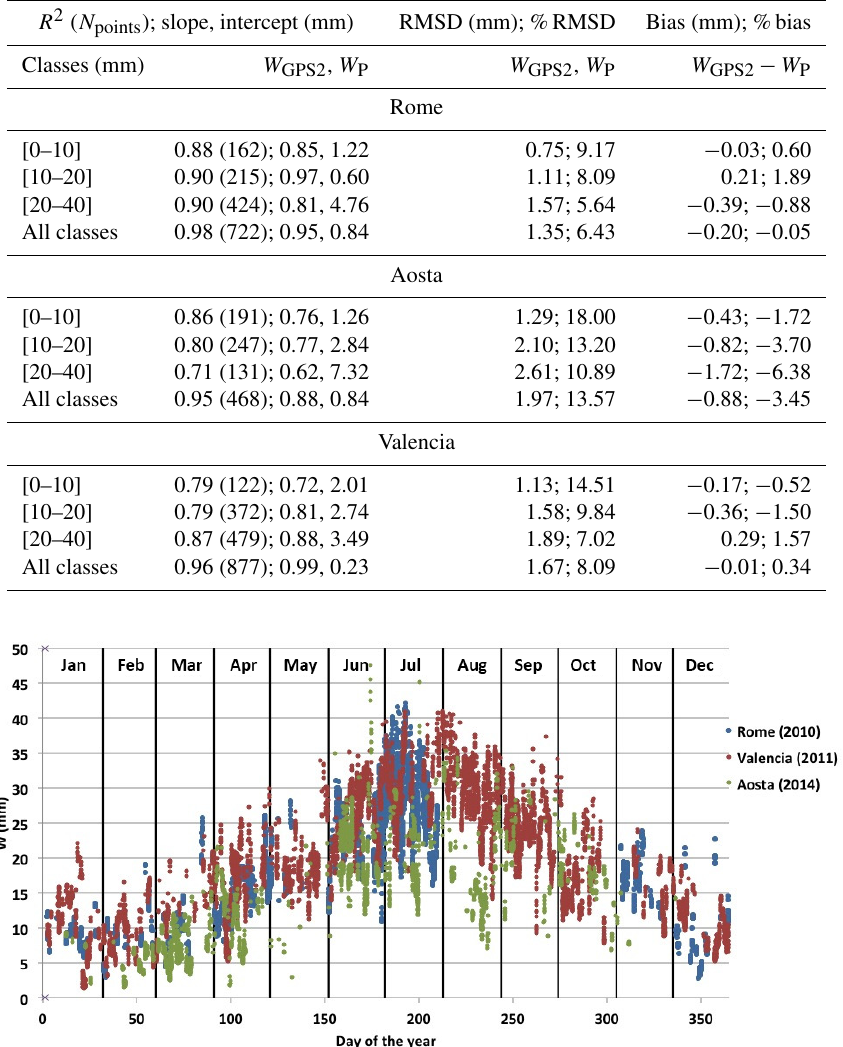
Figure 3. Temporal behaviours of WP retrieved with the presented methodology for the years 2010 (Rome), 2011 (Valencia) and 2014